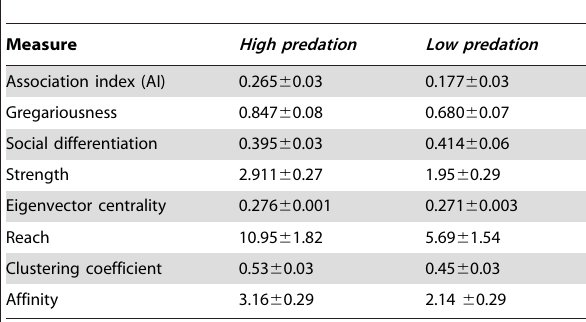
Table 3. Network association measures averaged over sampling periods (days) and populations to give overall means and standard errors for high (n=7) and low risk (n= 5)